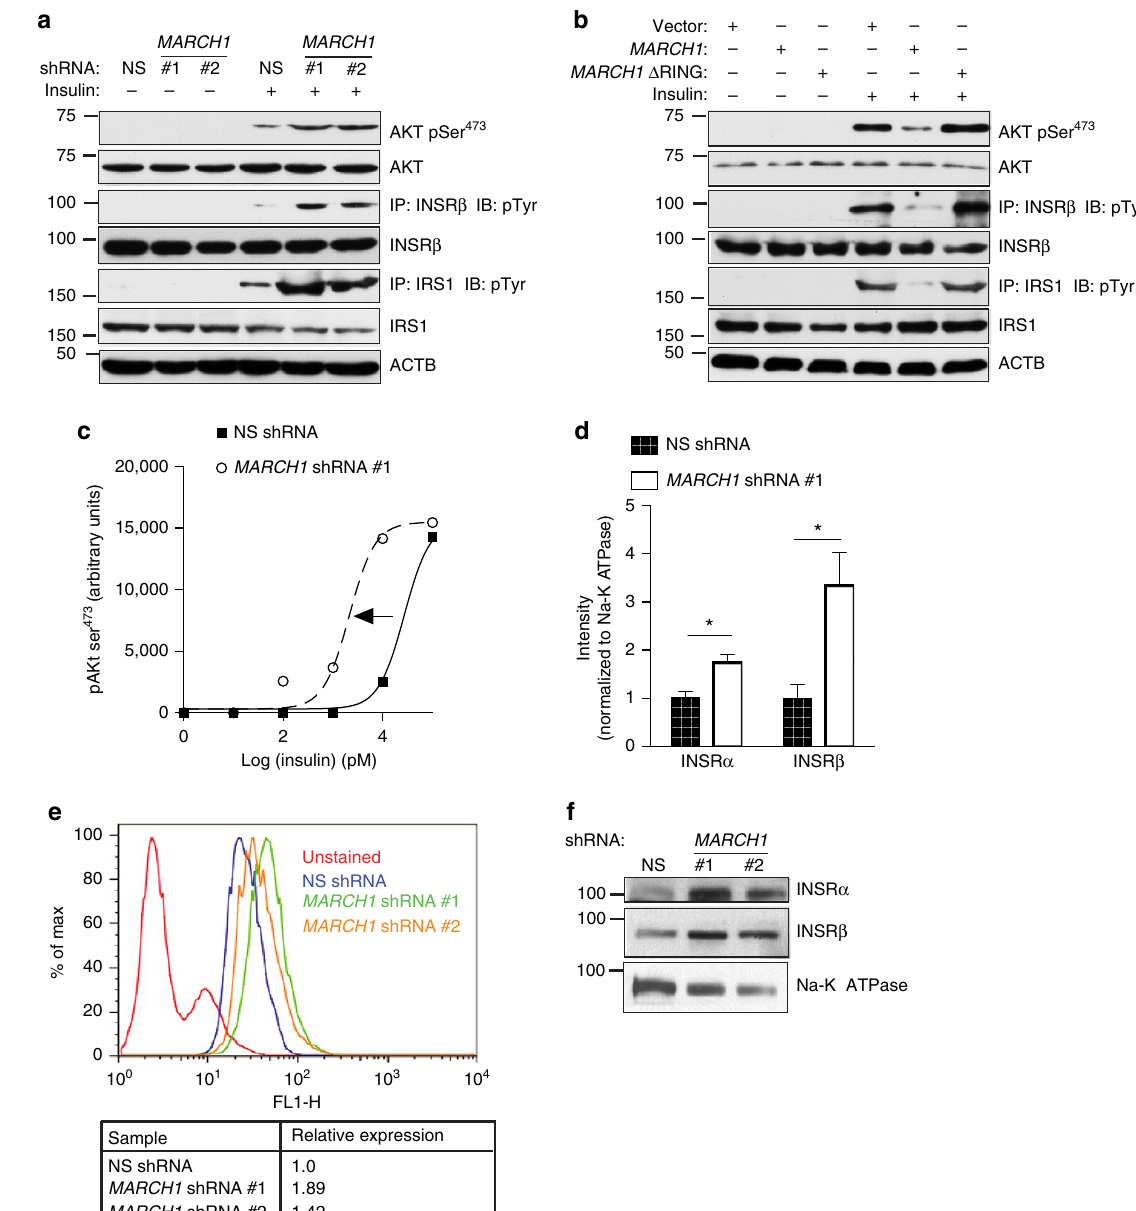
Figure 7 | MARCH1 regulates insulin sensitivity by controlling surface INSR expression. ( a ) Immunoblot analysis of insulin-stimulated INSR, IRS-1 and AKT activation in HeLa cells expressing the indicated shRNAs. ( b ) Immunoblot analysis of insulin-stimulated INSR, IRS1 and AKTactivation in HeLa cells expressing the indicated constructs. ( c ) Insulin dose–response curves in HeLa cells expressing NS or MARCH1 shRNA #1, constructed using AKT pSer 473 immunoblot densitometry (see also Supplementary Fig. 6d). ( d ) Biotinylation assay for cell surface expression of INSR a and INSR b in serum-starved HeLa cells expressing NS or MARCH1 shRNA #1, normalized to Na-K ATPase intensity (see also Supplementary Fig. 7a). ( e ) Flow cytometric measurement of surface INSR a in HeLa cells expressing the indicated shRNA. ( f ) Immunoblot analysis for cell surface expression of INSR a and INSR b in GPMVs isolated from serum-starved HeLa cells expressing indicated shRNAs. Data are mean ± s.e.m. In ( d ), n ¼ 3 biological replicates. In all panels, * P o 0.05, comparisons by unpaired t -test.